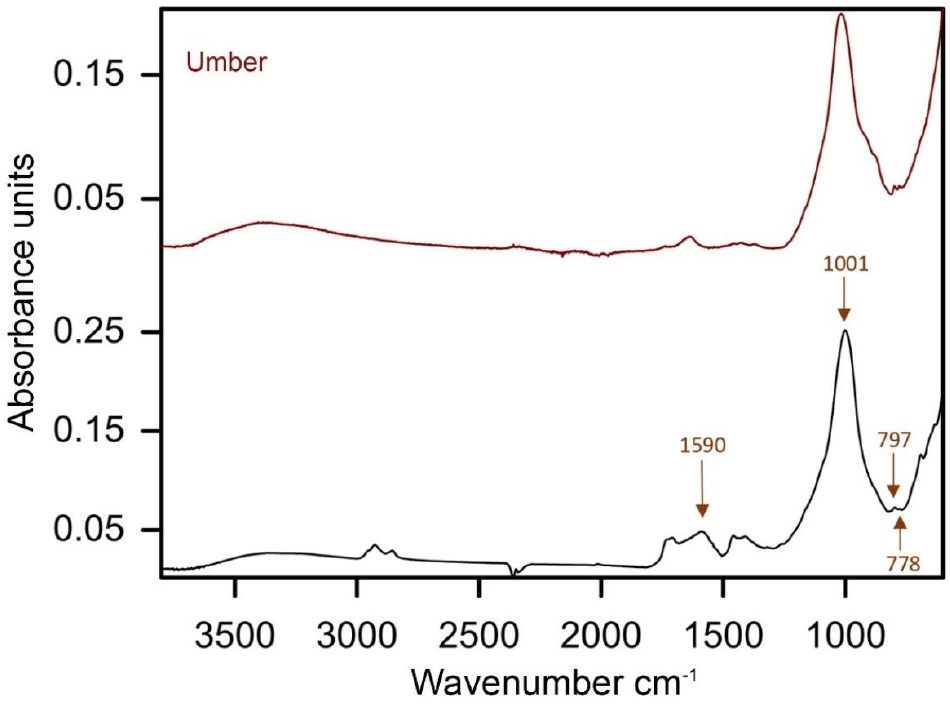
Figure 11. ATR–FTIR spectra of the brown paint of sample 4 extracted from Mount Huangshan (1987), with labelled marker peaks of umber and reference spectra of the same pigment.